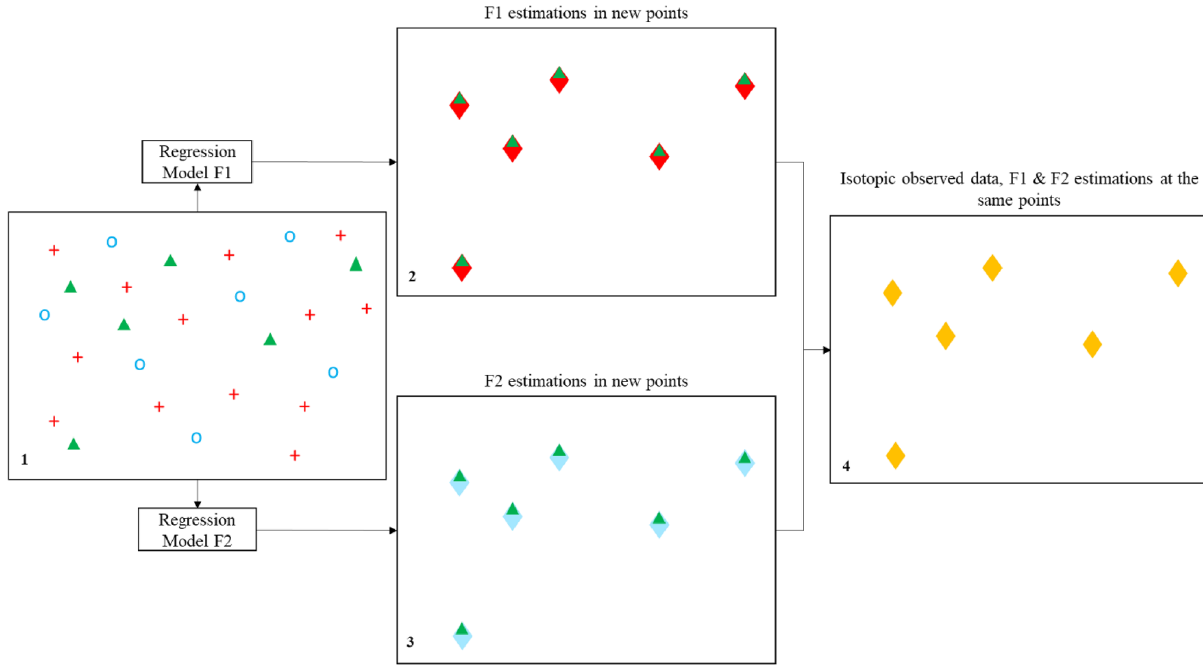
Figure 1. Workflow scheme for estimating isotopic values by using two independent parameters that are available in different locations than the isotopic measurements. Blue circles and red crosses represent two independent features that are potential candidates affecting the green triangles (isotopic precipitation composition). (1) Imaginary map of all available points. Green triangles are points with field isotopic measurements, and red crosses and blue circles are two independent parameter measurements. (2, 3) Estimation of the red and blue parameters from the constructed F1 and F2 regression models at the location points where isotopic data are available. (4) As a result of the algorithms, in the yellow diamonds, estimated red and blue data and measured green (isotopic composition) data are